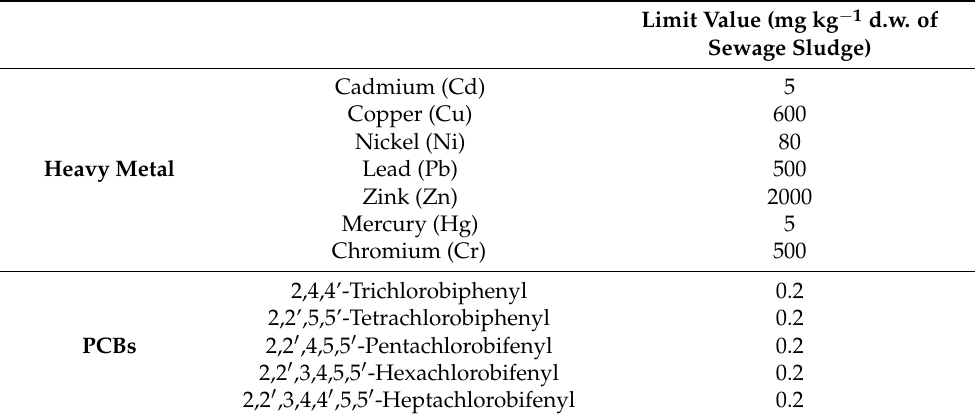
Table 1. Limits of Cd, Cu, Ni, Pb, Zn, Hg and Cr, and of polychlorinated biphenyls (PCBs), for sludge used in agriculture (mg kg − 1 d.w. of sewage sludge) [17].